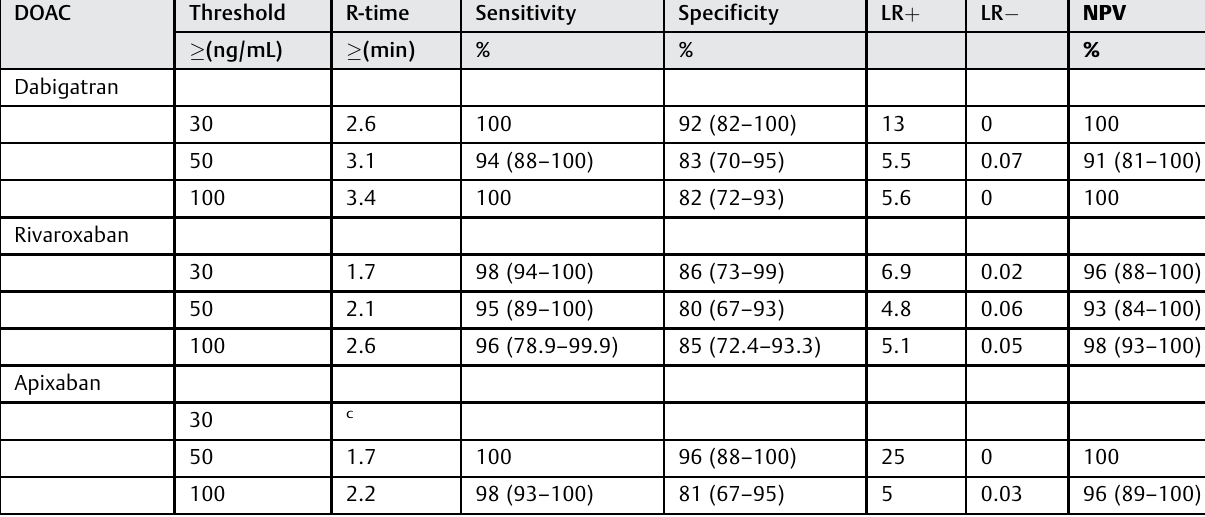
Table 2 Sensitivity, speci fi city and negative predictive value of R-time to detect DOAC concentrations above thresholds mentioned